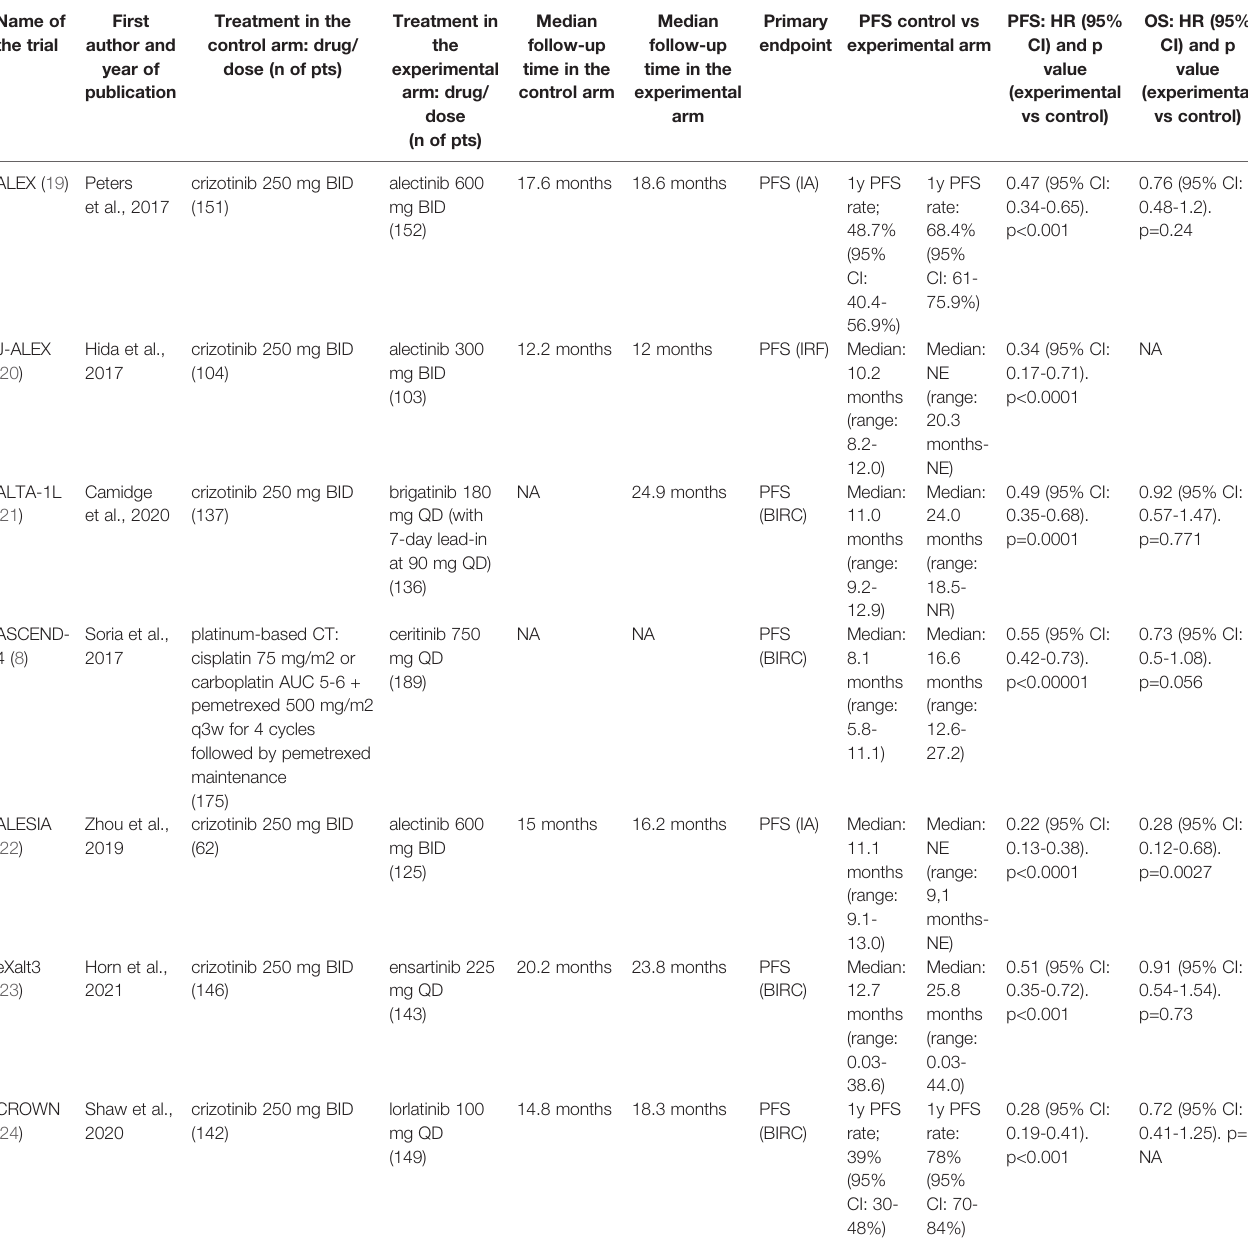
TABLE 1 | Characteristics and main outcomes of selected randomized clinical trials in patients with ALK-translocated lung cancer. Name of the